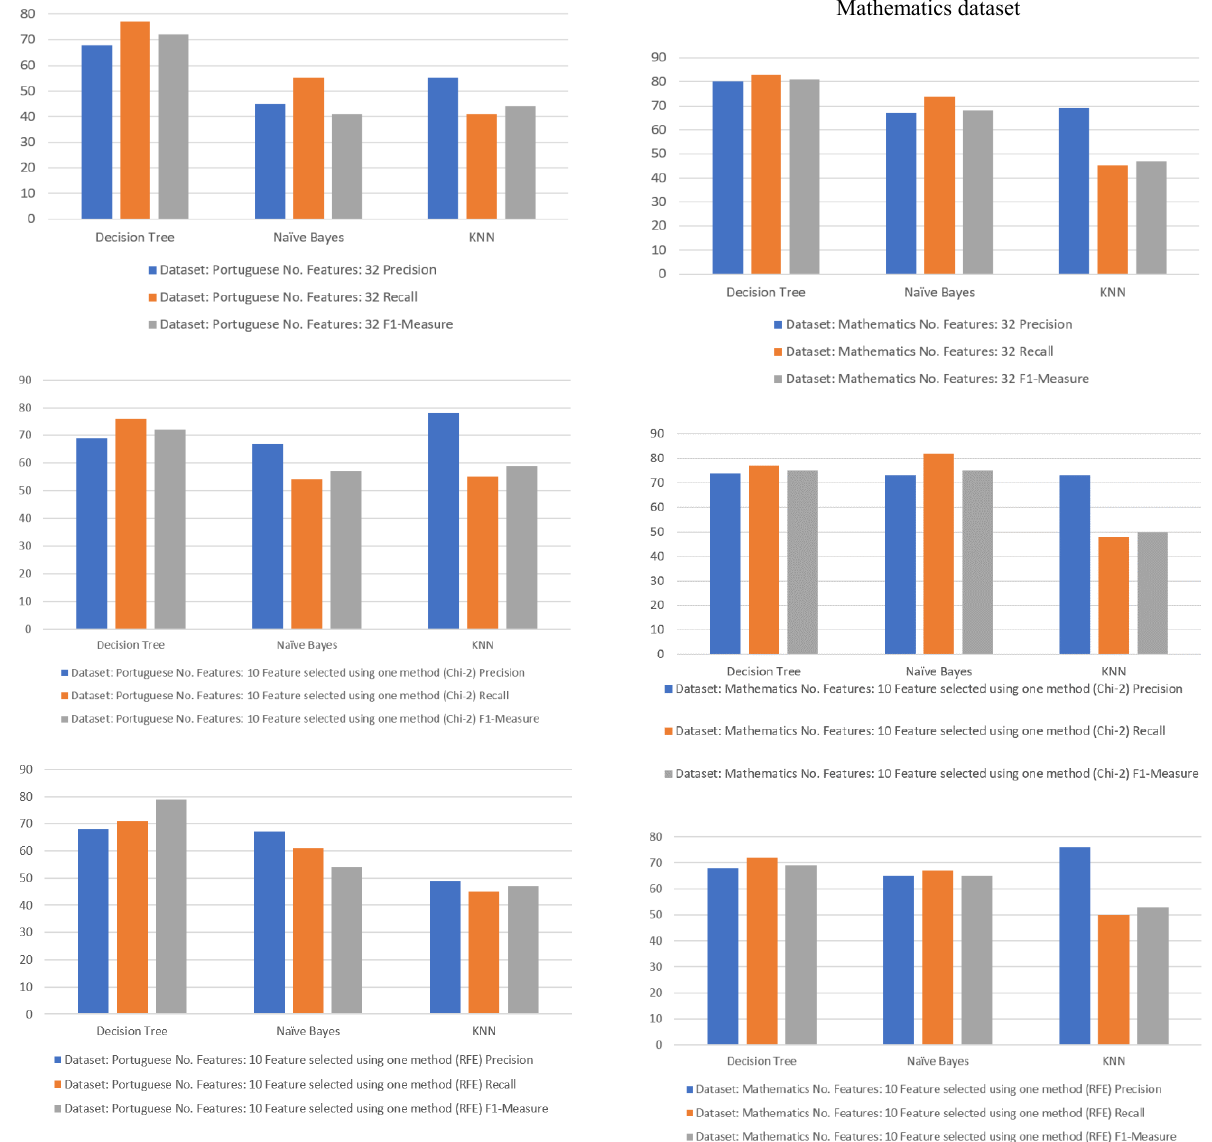
Fig. 3. Classification report comparative graph